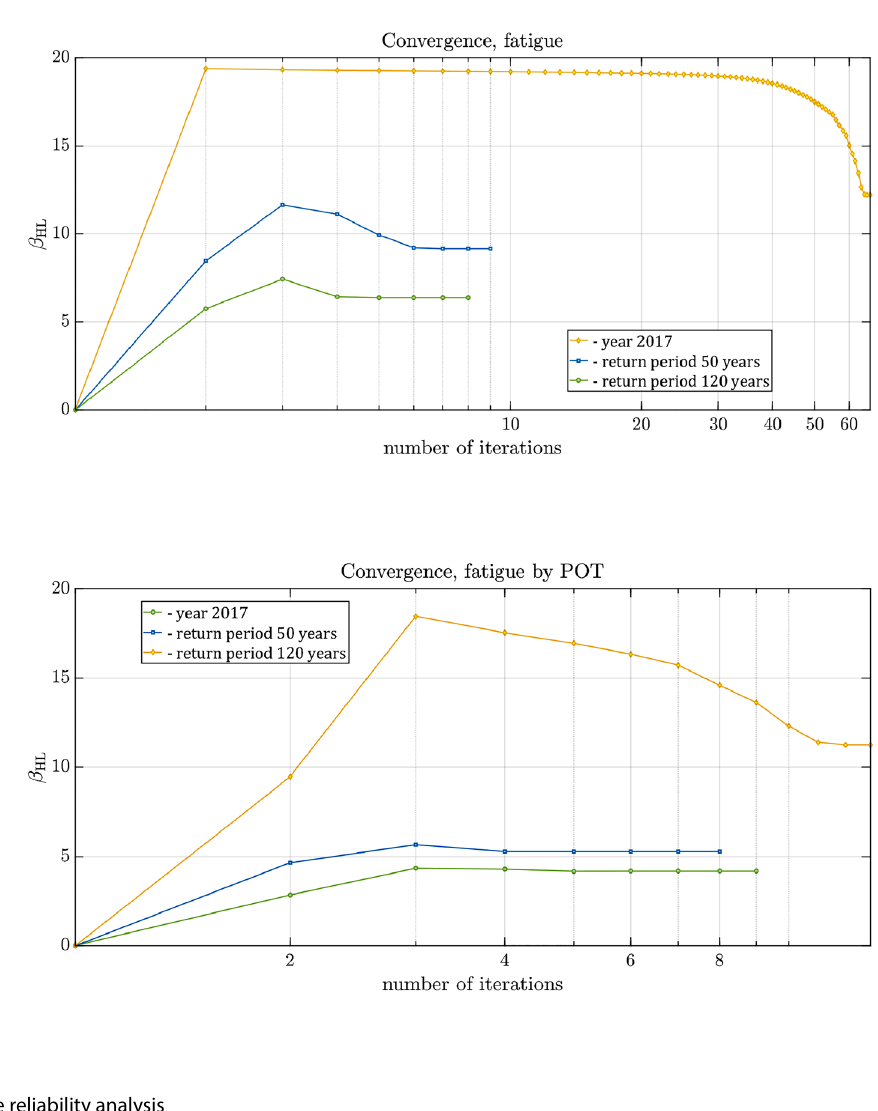
Table 4 Results of the fatigue reliability